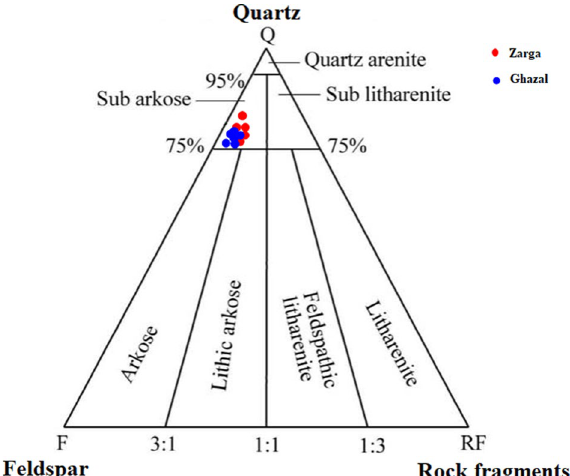
Figure 13. Classification of sandstones in the study area (created from information in reference 33 ).